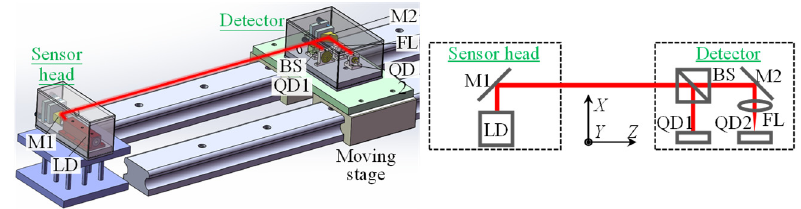
Figure 1. Schematic of the LD-based system.